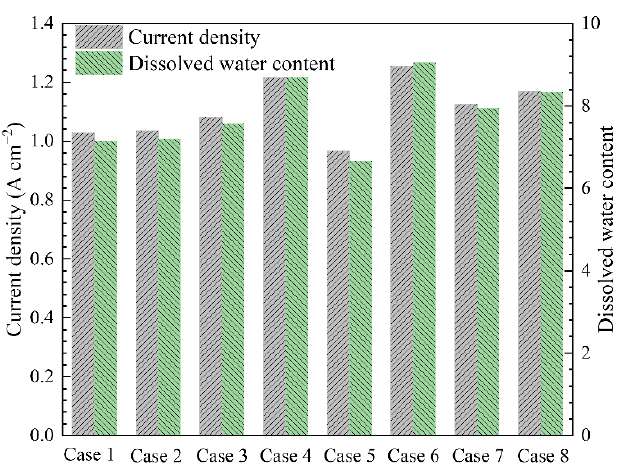
Figure 9. Comparison of fuel cell performance of various designs.